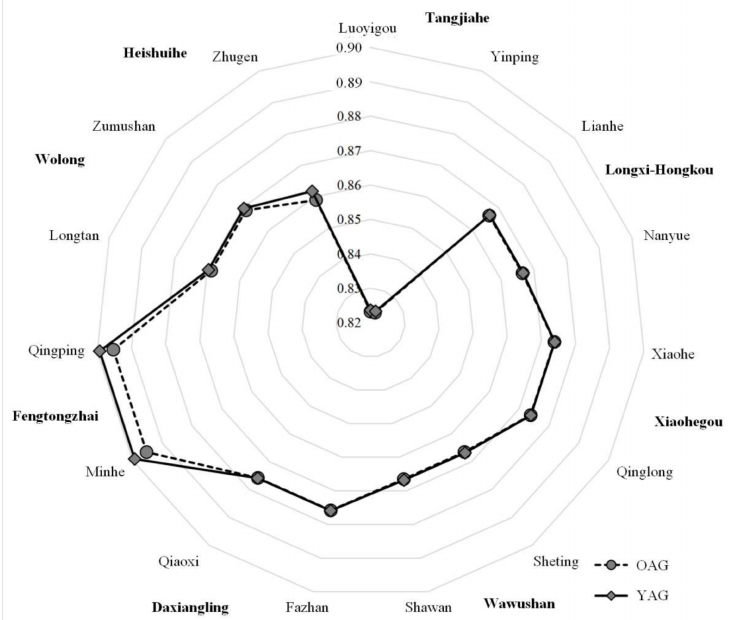
Figure 5. Ecological Niche Overlap Index between a part of communities and their neighbor- ing